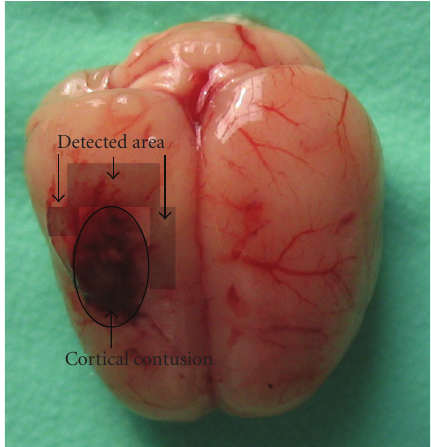
Figure 1: Schematic representation of the cortical contusion area induced by weight-dropping trauma and the studied region surrounding the injured